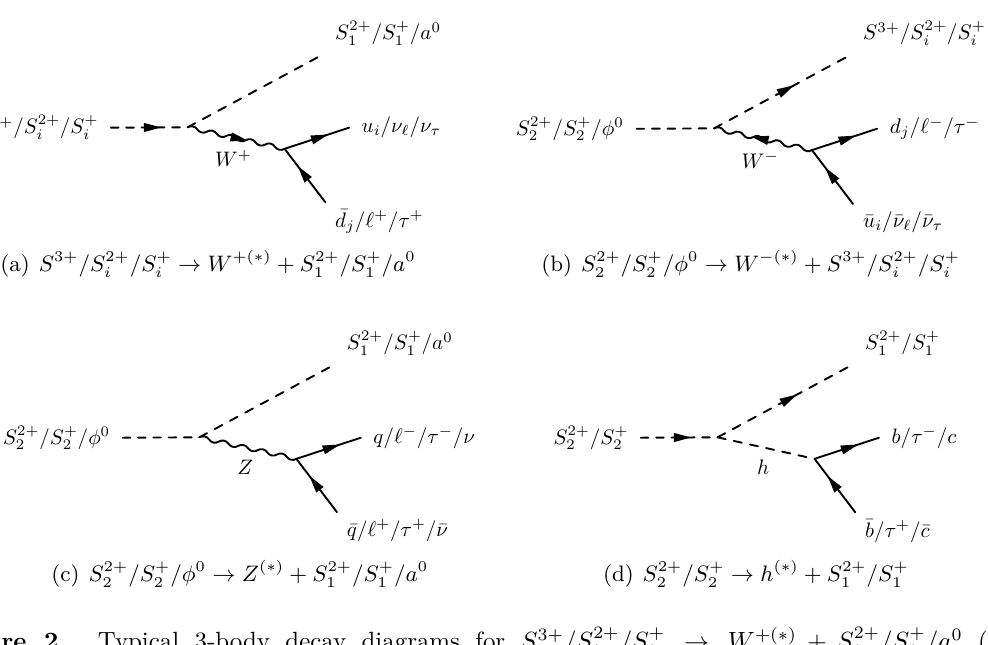
/S + → W +( ∗ ) + S 2+ i i /S + (b), S 2+ /S + /φ 0 → Z ( ∗ ) + S 2+ /S + /a 0 (c), and S 2+ 2 2 1 1 i i